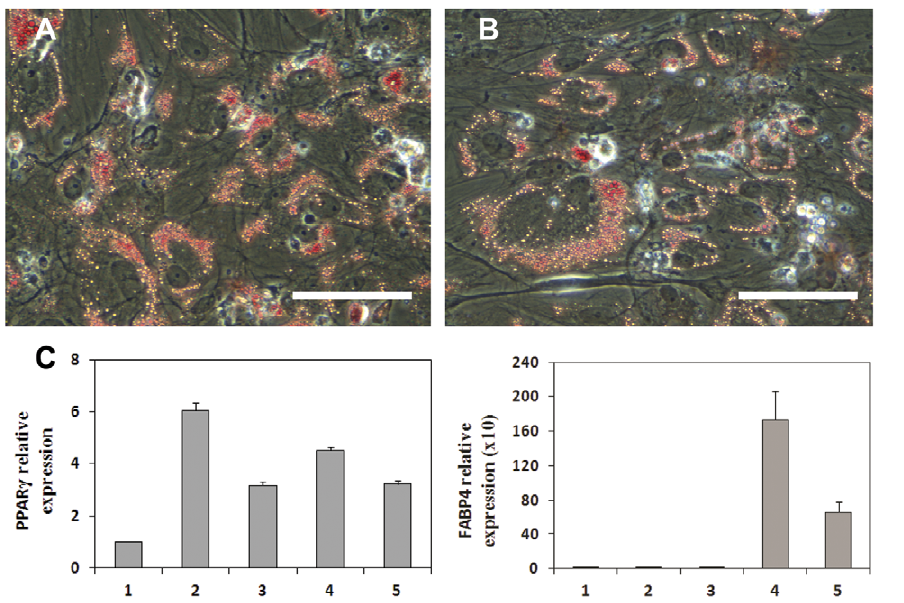
Figure 6. Invitro adipogenic differentiation. Oil red O staining of the 21 day adipogenic cultures was positive in both (A) MSC-like cells derived from H9-hESC and (B) MSC-like cells derived from YK26-iPS cells. Scale bars: 0.1 mm. (C) RT-qPCR analysis for mRNA expression of adipogenic genes PPAR c and FABP4. 1: undifferentiated H9-hESC; 2 and 3: MSC-like cells that derived from H9-hESC and YK26-iPS cells, respectively, before adipogenic differentiation; 4 and 5: 21 day adipogenic cultures of the MSC-like cells derived from H9-hESC and YK26-iPS cells,